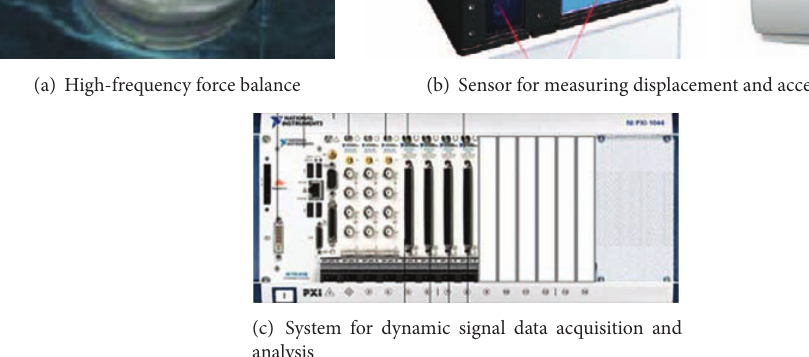
Figure 4: Major devices.